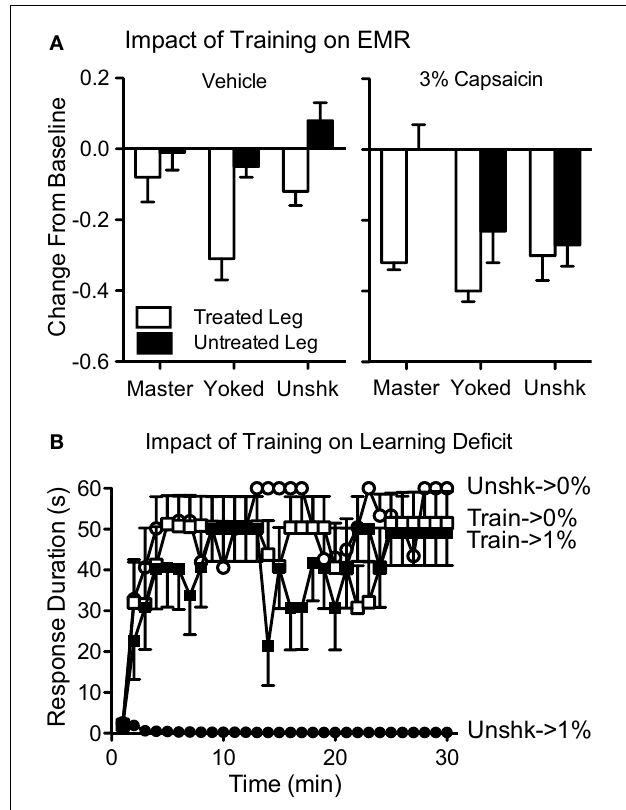
FIGURE 7 |Training with controllable shock attenuates the EMR and learning deficit observed after peripheral capsaicin. (A) Spinally transected rats received controllable shock (Master), uncontrollable shock (Yoked) or nothing (Unshk).They then received an intradermal injection of capsaicin (3%) or its vehicle into the paw of the pretreated leg. Mechanical reactivity was tested using von Frey stimuli applied to the treated, or untreated, leg. In vehicle treated rats, uncontrollable shock enhanced reactivity on the treated leg. Capsaicin induced a robust bilateral EMR in both theYoked and Unshk groups.Training with controllable stimulation (Master) eliminated the EMR observed on the contralateral (Untreated) leg. (B) Transected rats received instrumental training (Train) or nothing (Unshk), followed by a peripheral injection of capsaicin (1%) into the paw of the same leg.The next day, rats were tested with response-contingent shock applied to the contralateral leg. Untrained rats that received capsaicin (Unshk → 1%) failed to learn. Prior training with controllable shock (Train → 1%) eliminated this learning deficit. Adapted from Hook et al.